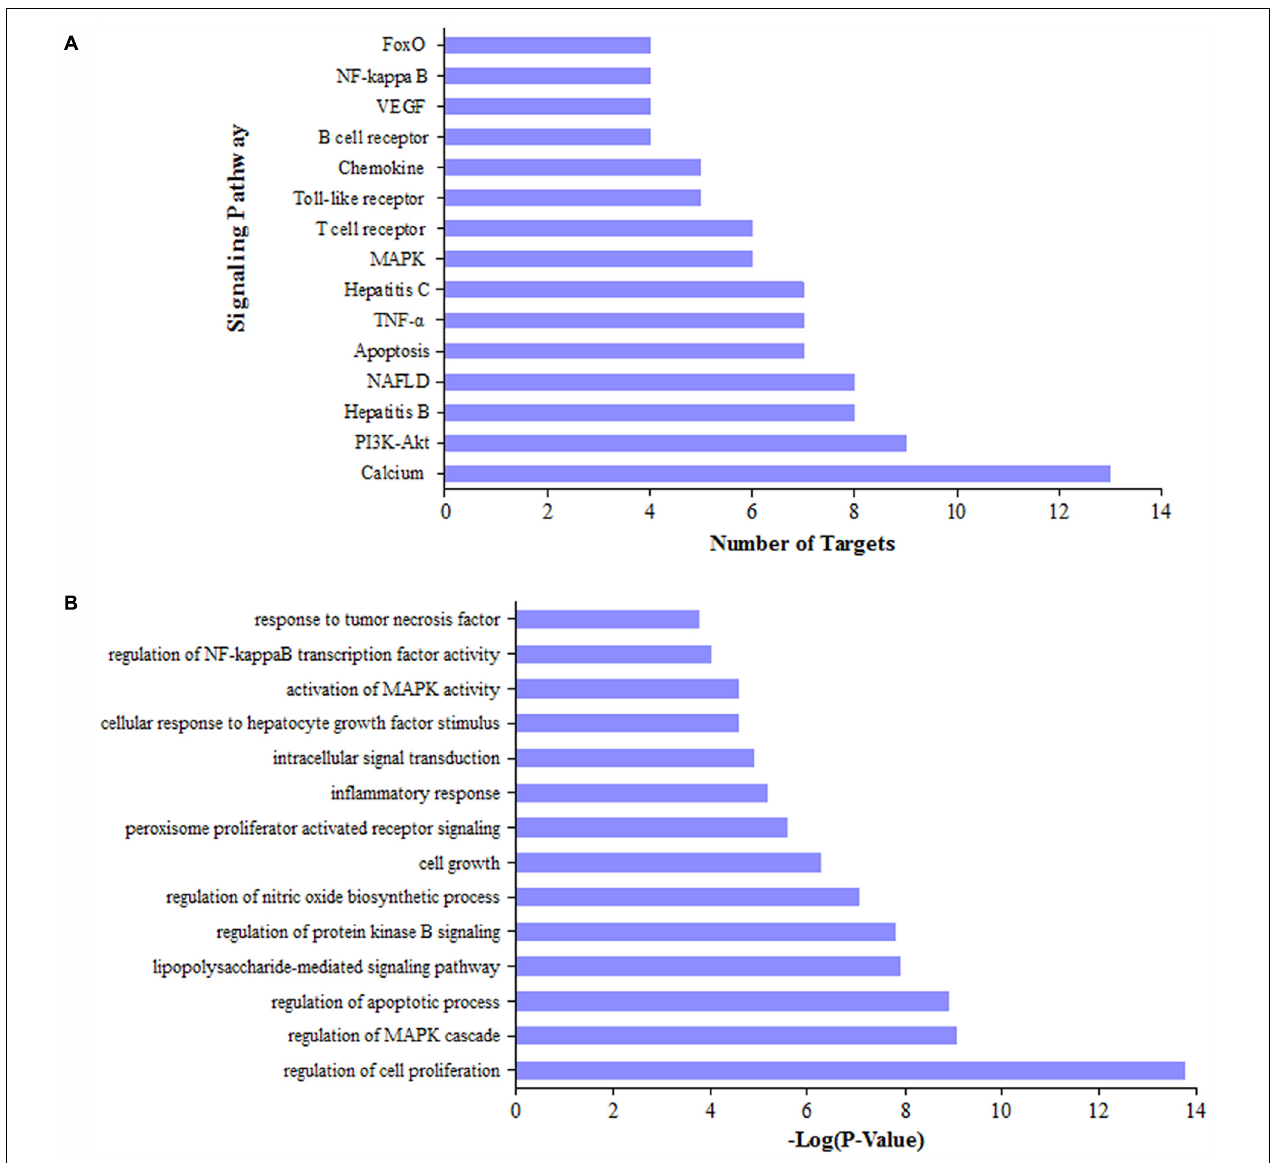
FIGURE 3 | Pathway and function analysis for potential targets of DGLHD. We selected the targets of active ingredients in DGLHD with the degree values over 3, then performed KEGG pathway enrichment analysis (A) and GO function analysis (B)